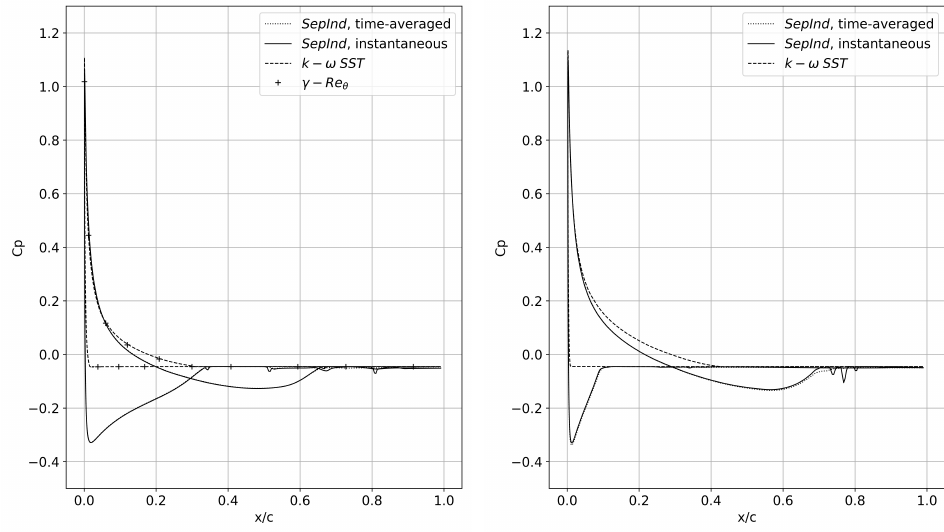
Figure 14. Predicted pressure coefficients under cavitating condition for AoA = 3 ◦ ( left ) and AoA = 5 ◦ ( right